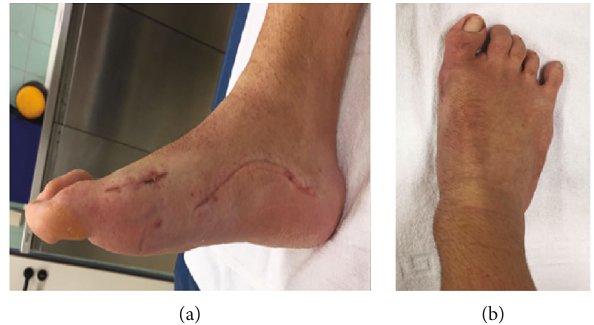
Figure 8: Photographs of the medial (a) and dorsal (b) side of the foot nine weeks postoperatively, displaying healed wounds, and corrected hallux valgus deformity, as well as an already signi fi cant decrease in volume of the plantar aspect of the